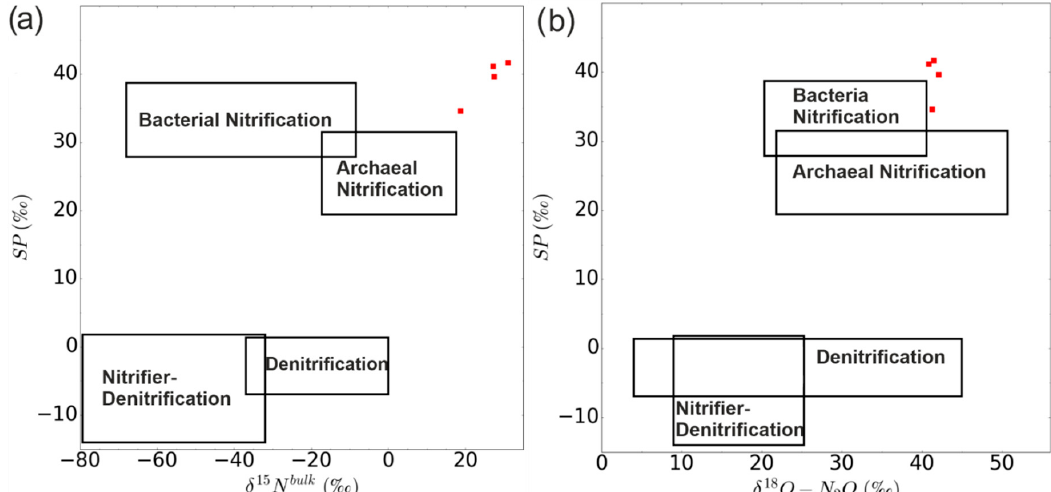
Figure 7. Dual isotope end-member map for N 2 O source partitioning before fertilization. Relation between δ 15 N bulk and SP ( a ) and the relation between δ 18 O and SP ( b ). The squares indicate typical ranges for the microbial processes of N 2 O production. The red squares represent the isotope signatures of N 2 O emission on May 20, 21, 27, and 28 (shown in Figure 2c as red dots) before fertilization in this study. The rectangles are taken from Toyoda et al.